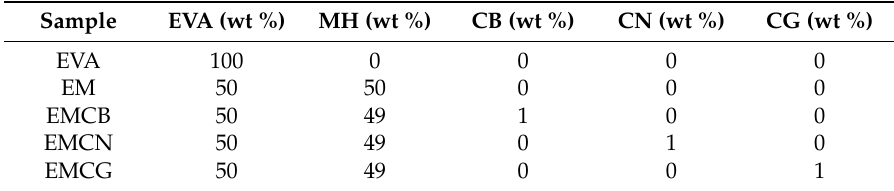
Table 1. Formulations of ethylene-vinyl acetate (EVA)